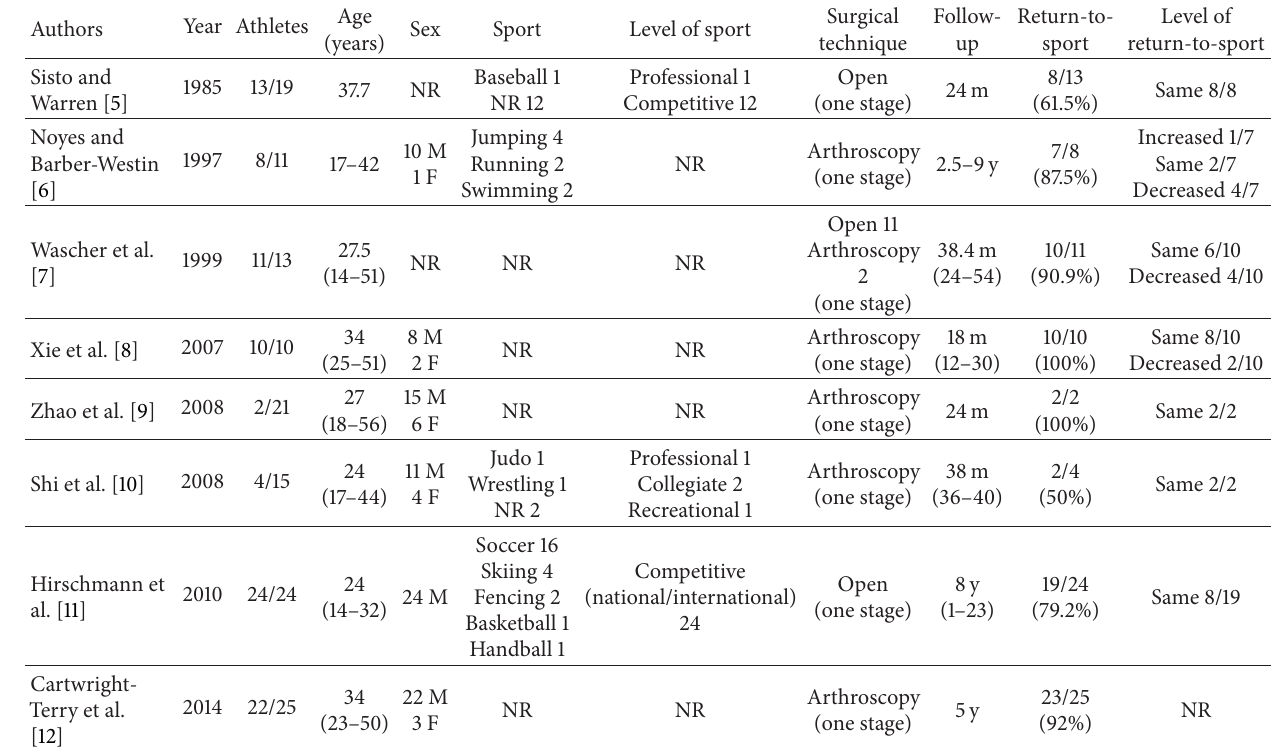
Table 2: Review of the literature.